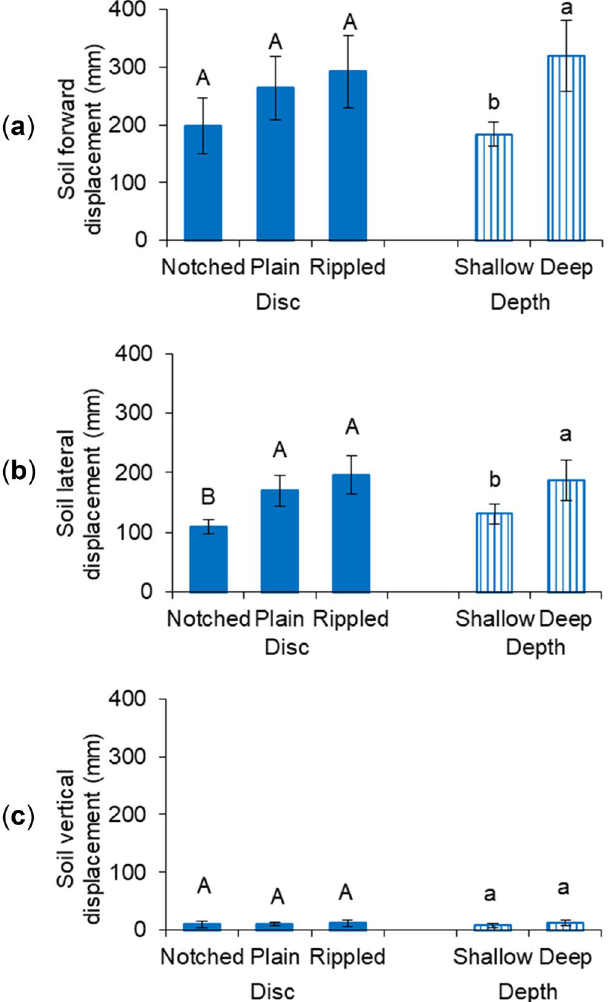
Figure 2. Soil displacements of different discs at different working depths in three directions: ( a ) forward, ( b ) lateral, and ( c ) upward; means followed by different lower case letters or upper case letters are significantly different according to Tukey’s test at the significance level of 0.05; error bars are standard deviations.